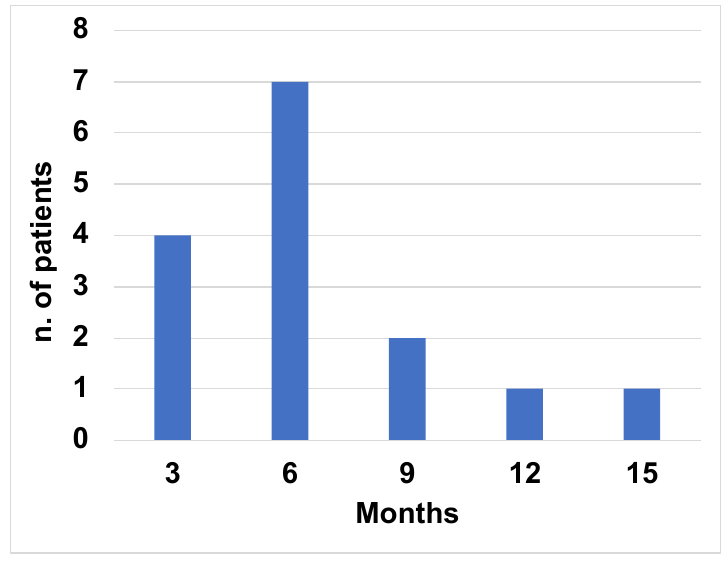
Figure 3. Frequency distribution of patients achieving CR at different time point of US follow up.